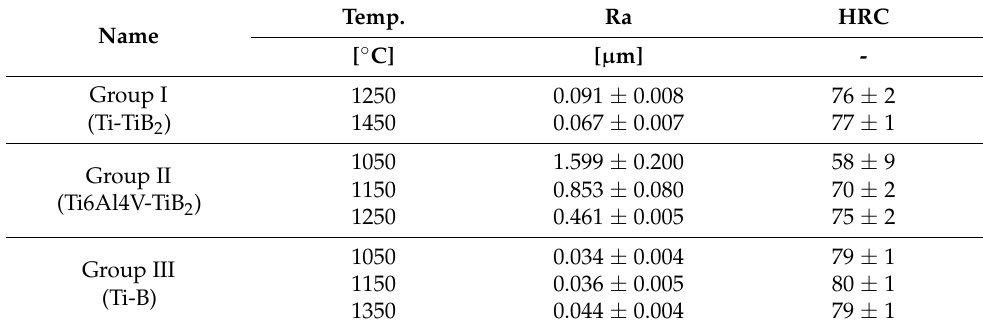
Figure 3. Optical images of the surfaces of composite samples after polishing process: ( a ) Group I (Ti-TiB 2 , 1250 °C); ( b ) Group II (Ti6Al4V-TiB 2 , 1050 °C); ( c ) Group III (Ti-B, 1350 °C). Table 1. The average roughness and hardness of the polished samples (before coating deposition).